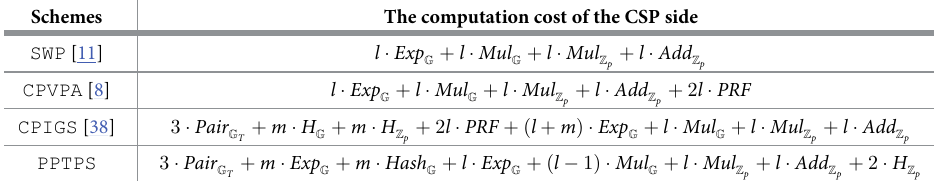
Table 3. The computation cost of the CSP side.